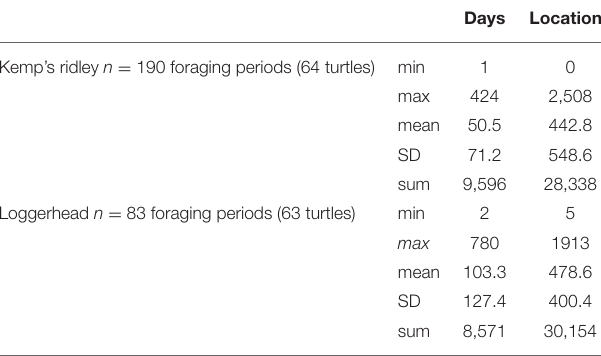
TABLE 2 | Foraging days and filtered locations.